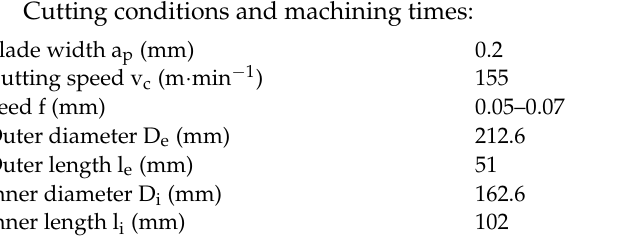
Figure 1. The machine SP280 SY workspace and details of cutting edge No.1 and No.2 inserts from cubic boron nitride (CBN).